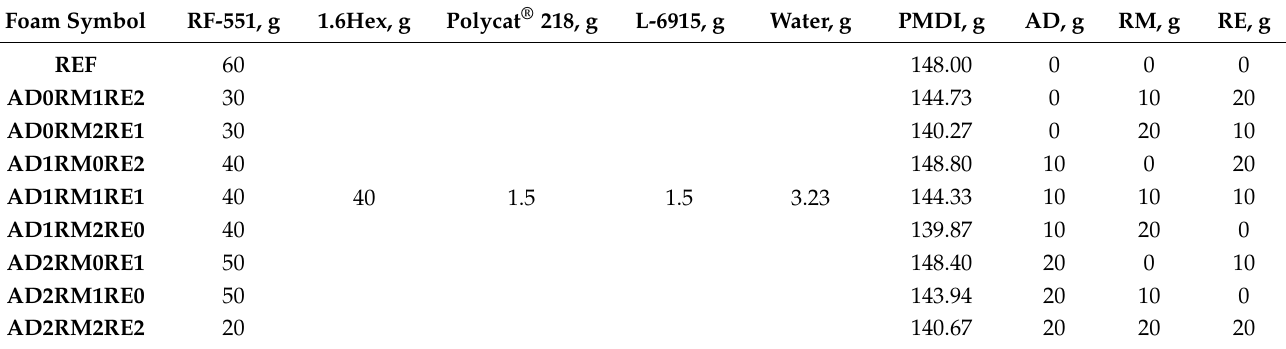
Table 9. Formulas of rigid polyurethane